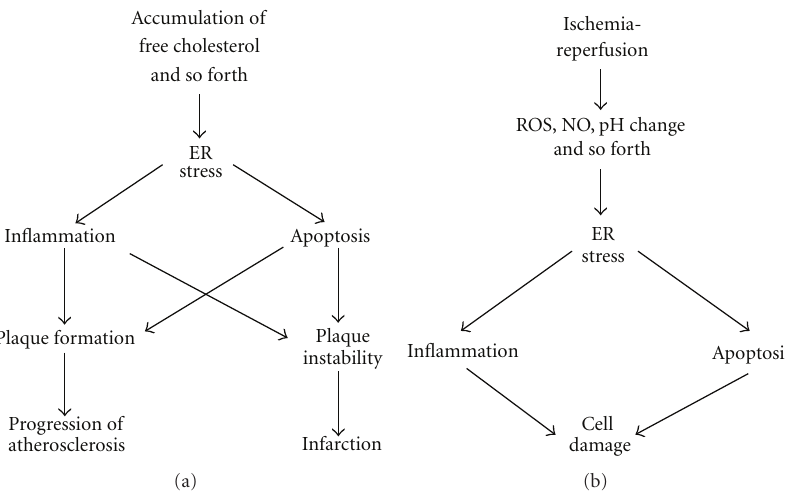
Figure 3: Involvement of ER stress response in atherosclerosis (a) and ischemia-reperfusion injury (b). See the text for details.